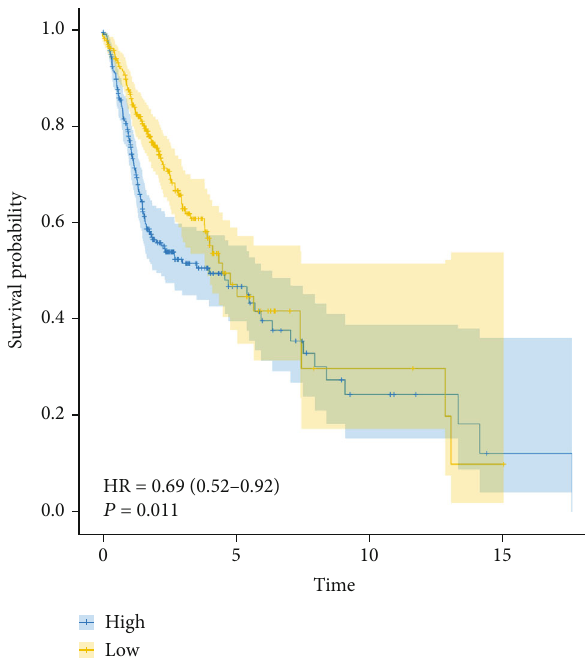
Figure 4: Survival curves for high- and low-risk score groups of patients with head and neck cancer.